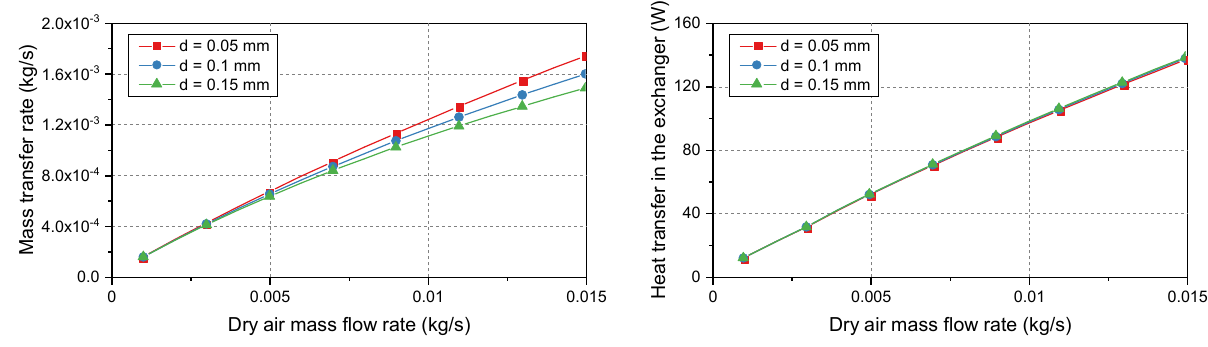
Figure 6. Effects of the membrane thickness on the humidifier performance. The number of membranes determines the shell diameter of the humidifier. Increas-